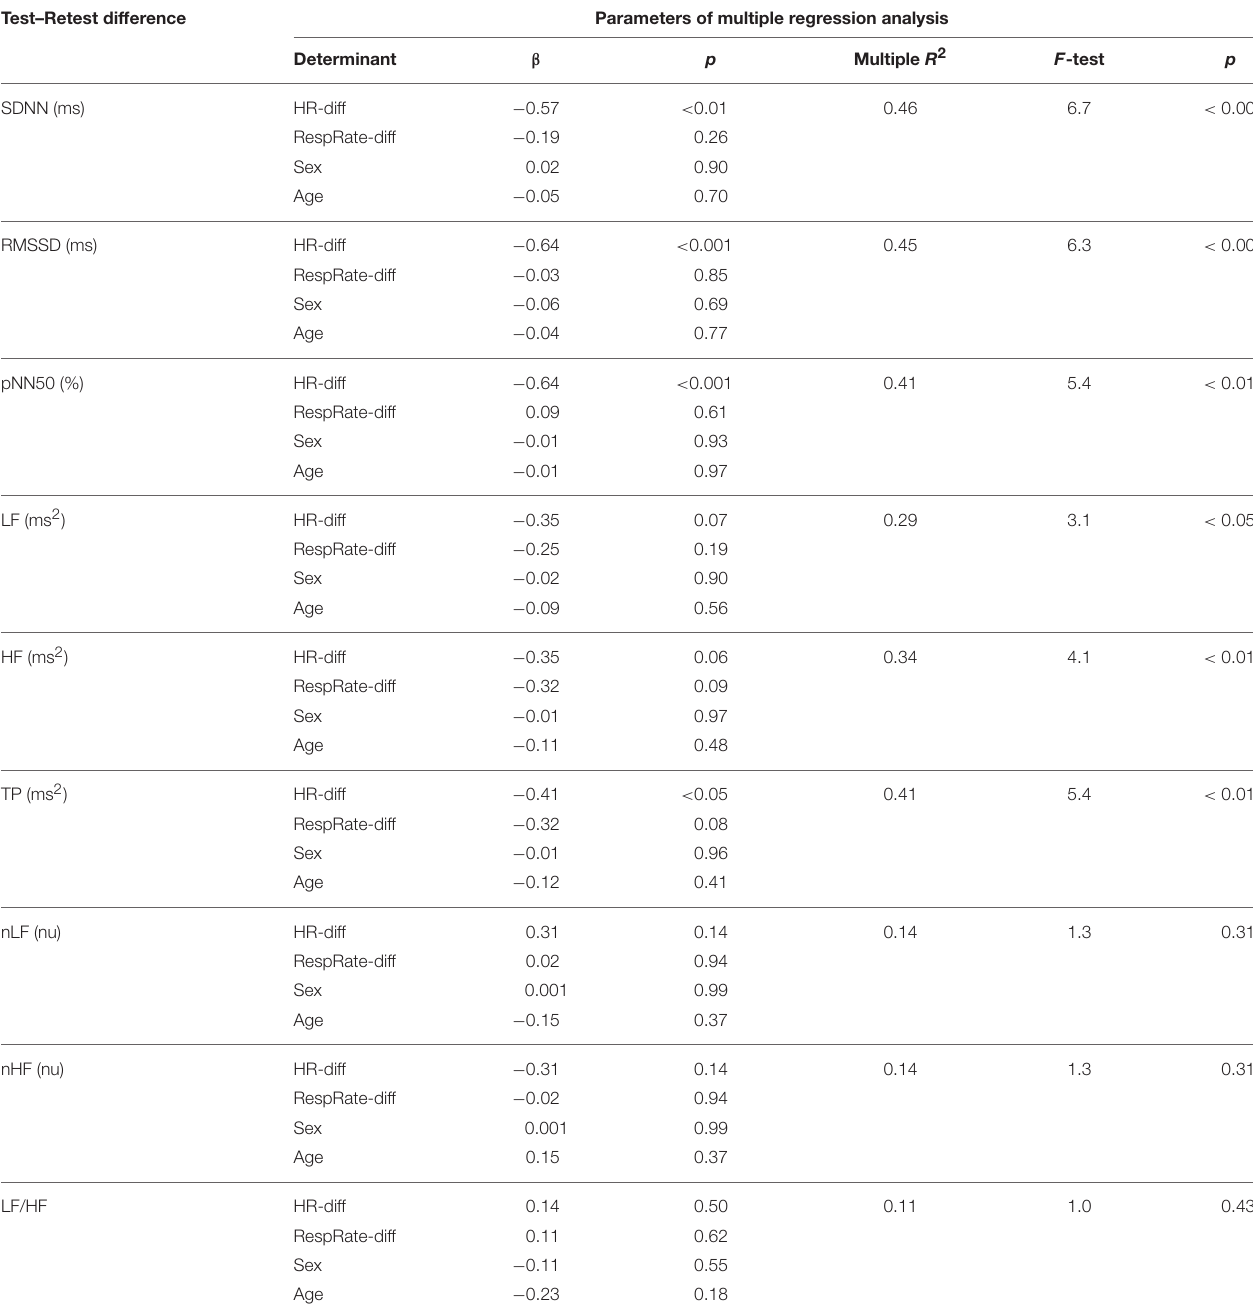
TABLE 2 | Results of the multiple regression analysis considering differences in HR (HR-diff) and RespRate (RespRate-diff), sex, and age as determinants of differences between Test and Retest in standard HRV